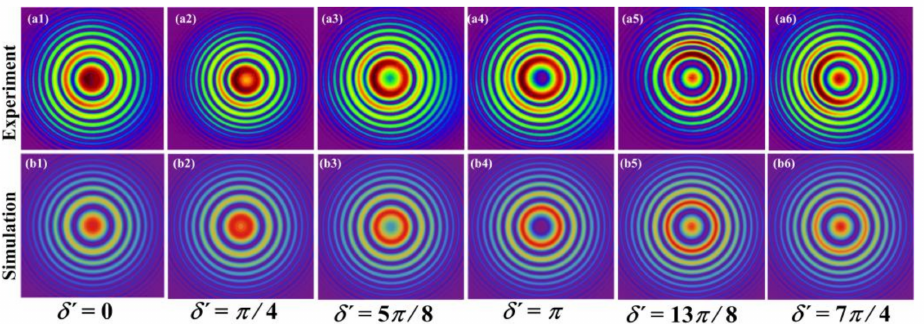
Figure 3. Effect of the effective phase difference δ (cid:48) between two Gaussian beams ( | l 1 = 0 (cid:105) ) on the interference light intensity at the beam center. Row ( a ) shows the experimental results, and row ( b ) shows the numerical simulation